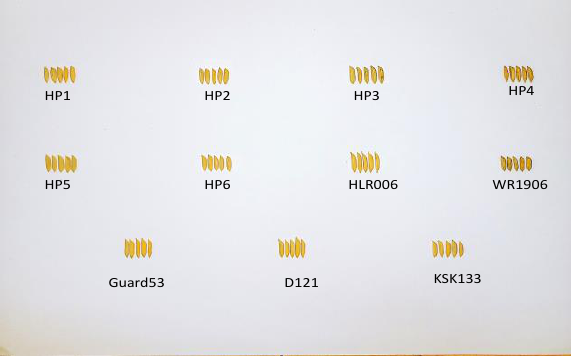
Figure 1. Seed morphology of ten rice hybrids and one open pollinated variety.